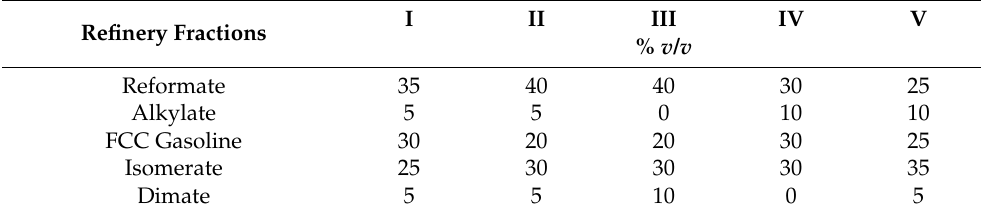
Table 2. Percentage of refinery fractions in the base